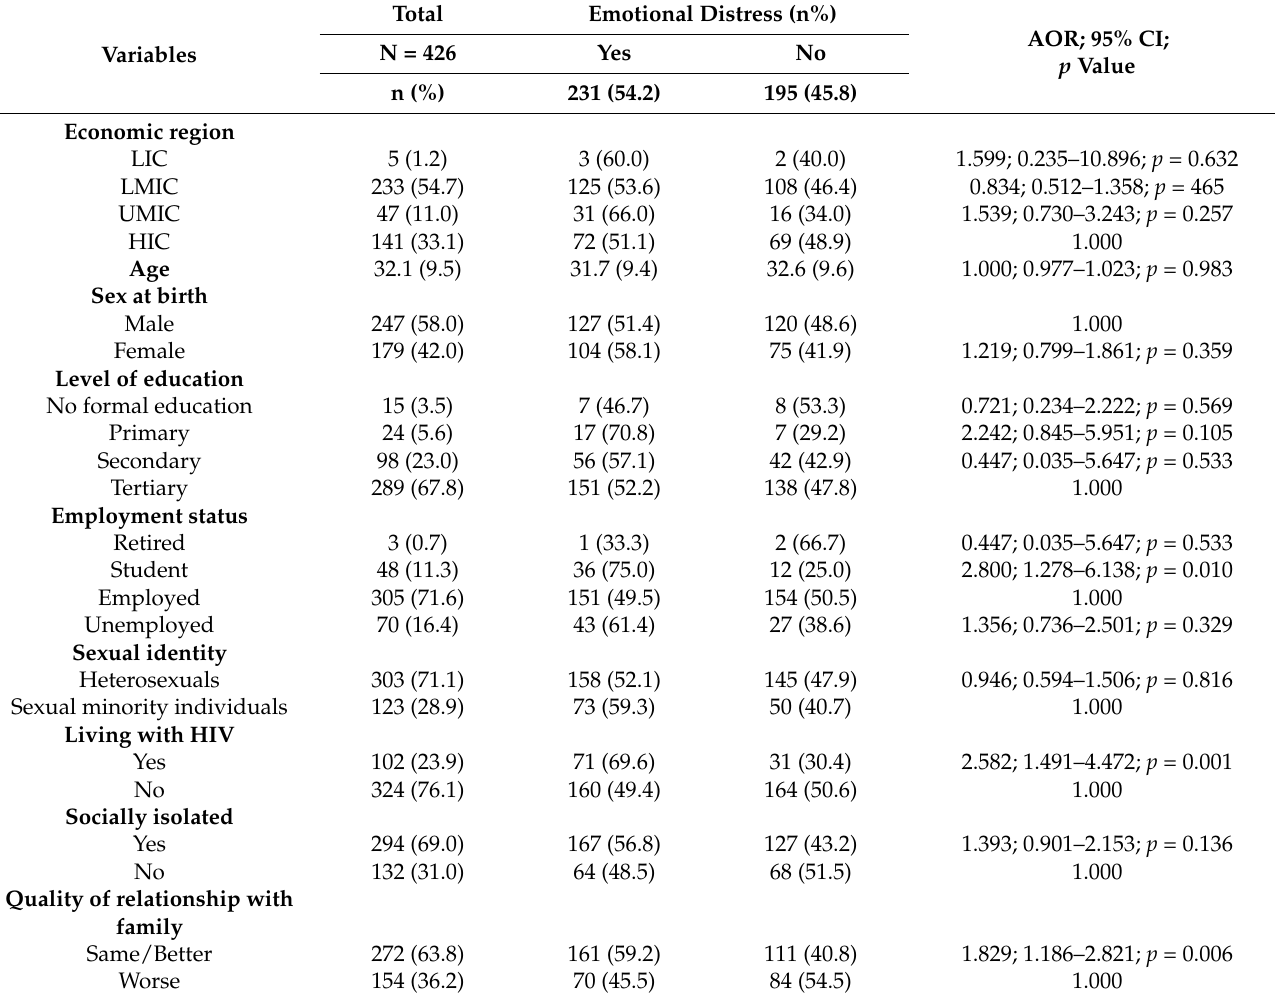
Table 1. Multivariate logistic regression analysis to determine factors associated with emotional distress for people who transacted sex during the first wave of the COVID-19 pandemic (N =